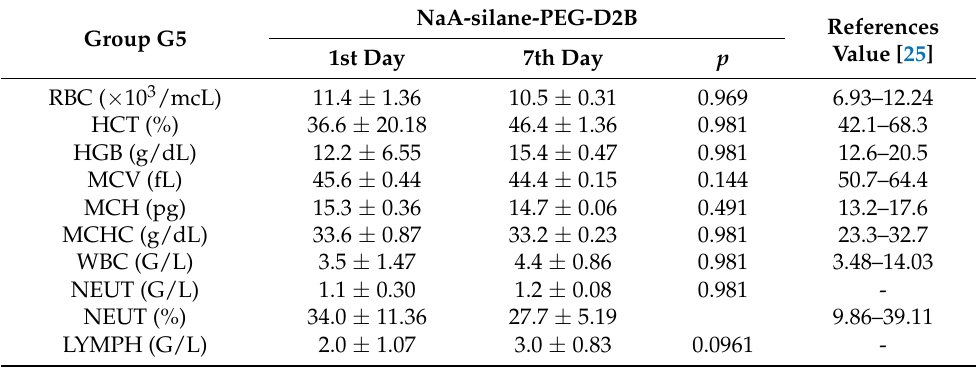
Table A6. Hematological parameters of blood of BALB/c mice at 1 and 7 days after injection with